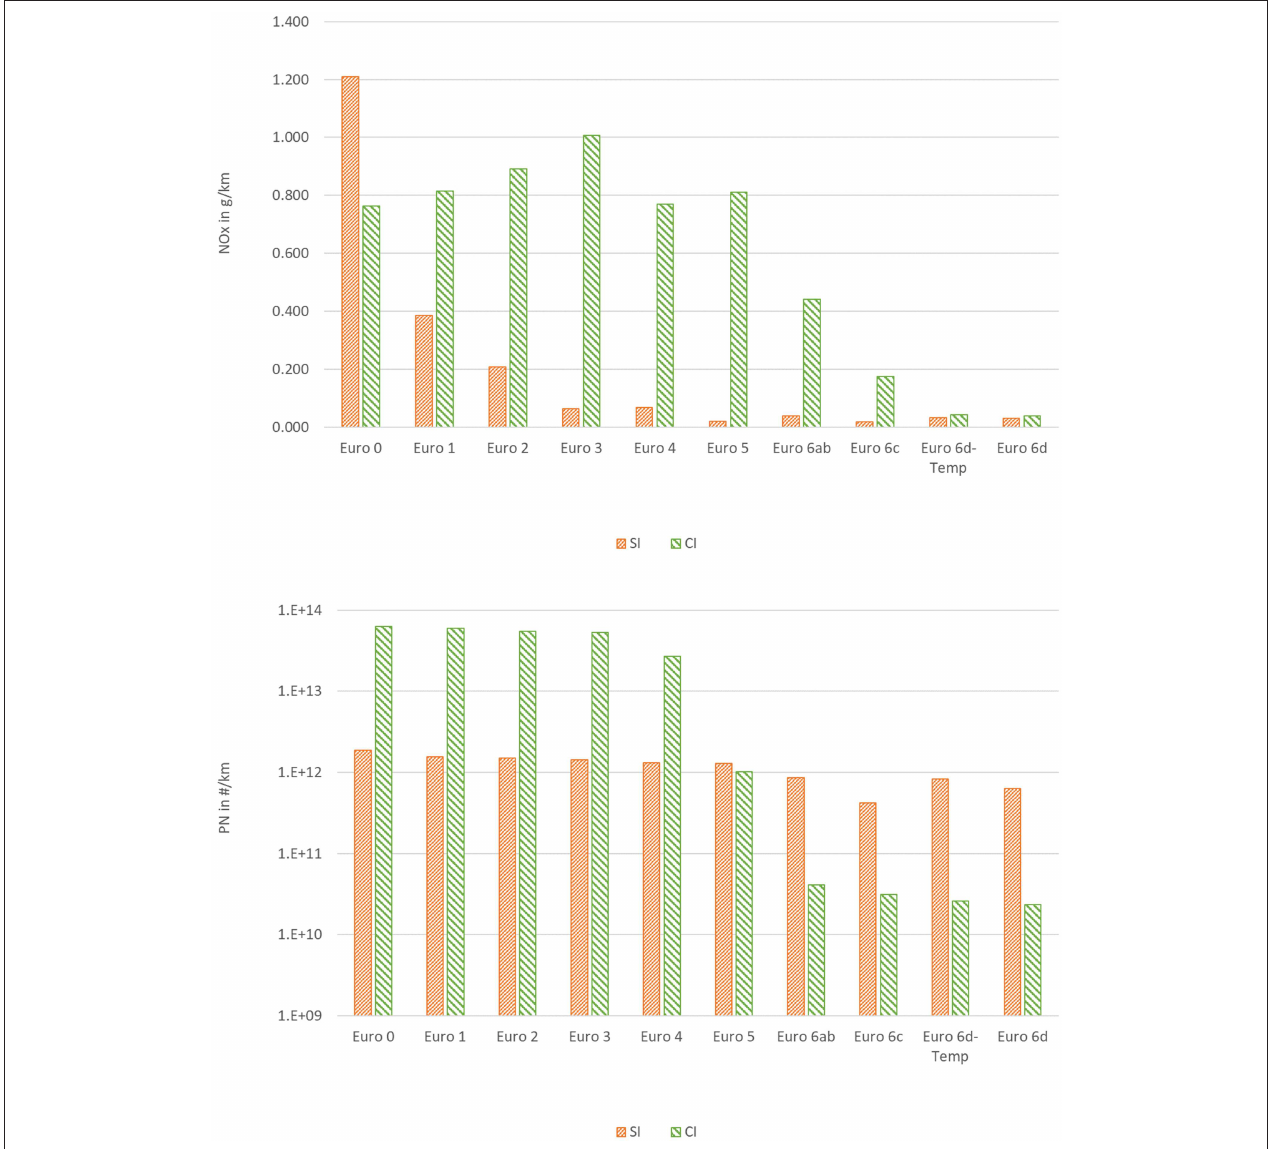
FIGURE 8 | Average hot NO x and PN emission factors of the passenger car segments for HBEFA (calibrated to German driving and vehicle conditions) adapted from Matzer et al. (2019) with permission of TU